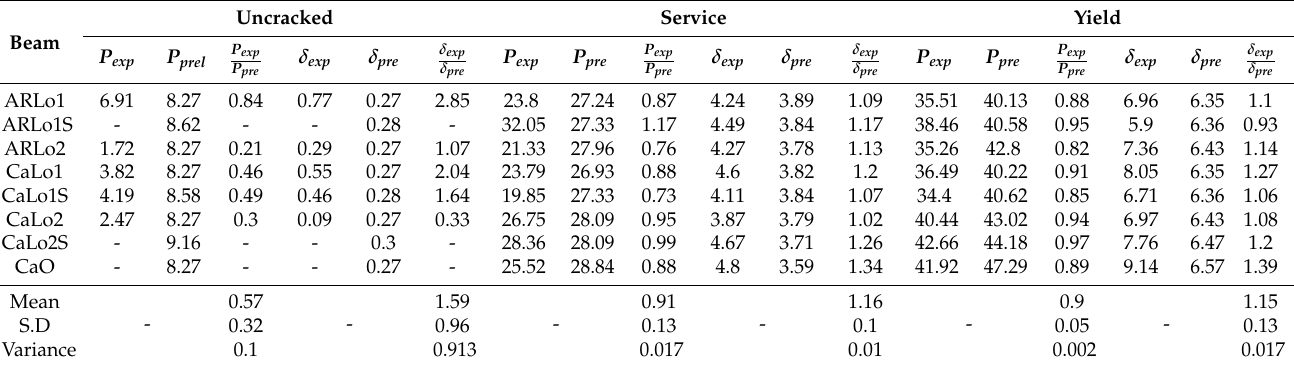
Table 7. Comparison between experimental and predicted results.